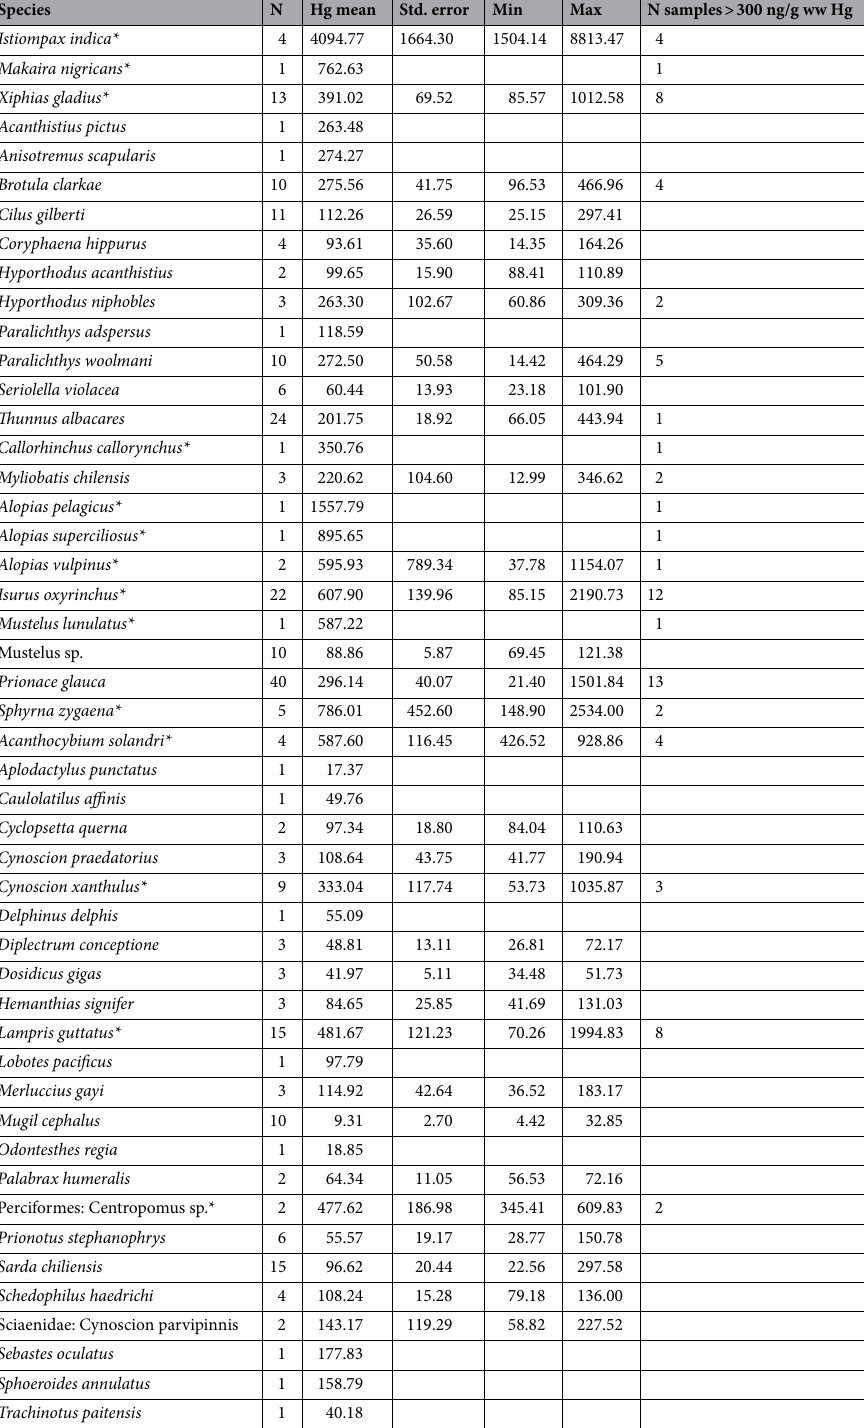
Table 1. Summary of the samples analysed for mercury content. Samples marked by (*) represent species with average (or single sample) mercury concentrations above the US EPA guideline of 300 ng/g